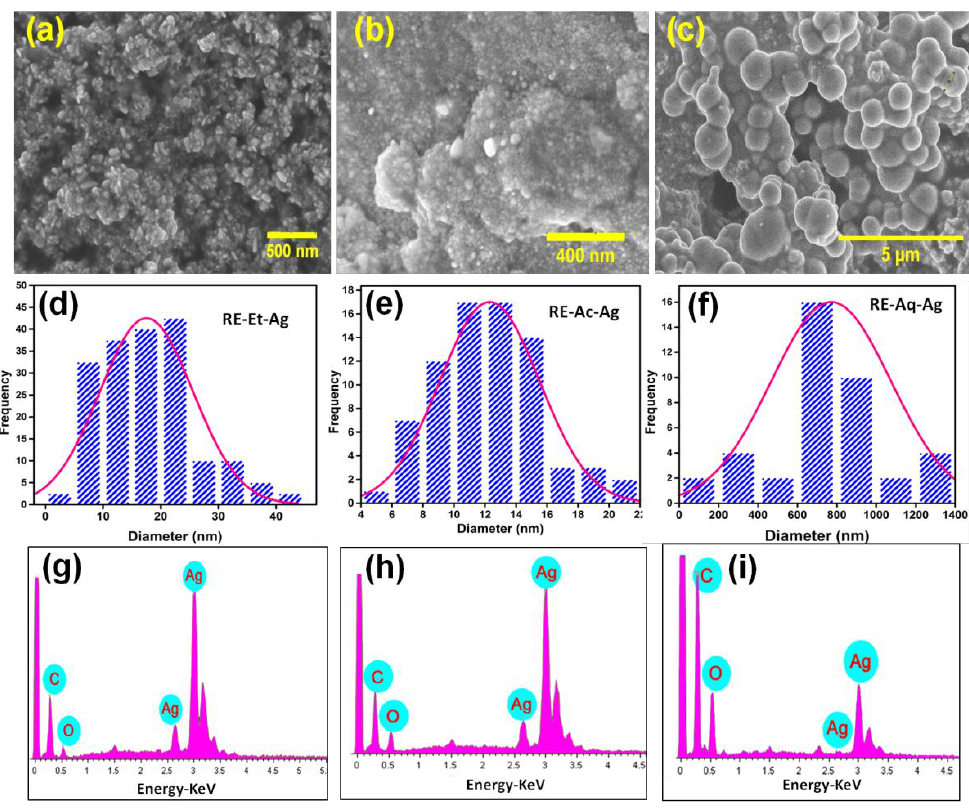
Figure 3. FESEM micrographs of AgNPs: ( a ) RE-Et-Ag, ( b ) RE-Ac-Ag, and ( c ) RE-Aq-Ag. ( d – f ) Average particle size of RE-Et-Ag, RE-Ac-Ag, and RE-Aq-Ag. ( g – i ) EDS spectrum of RE-Et-Ag, RE-Ac-Ag, and RE-Aq-Ag.